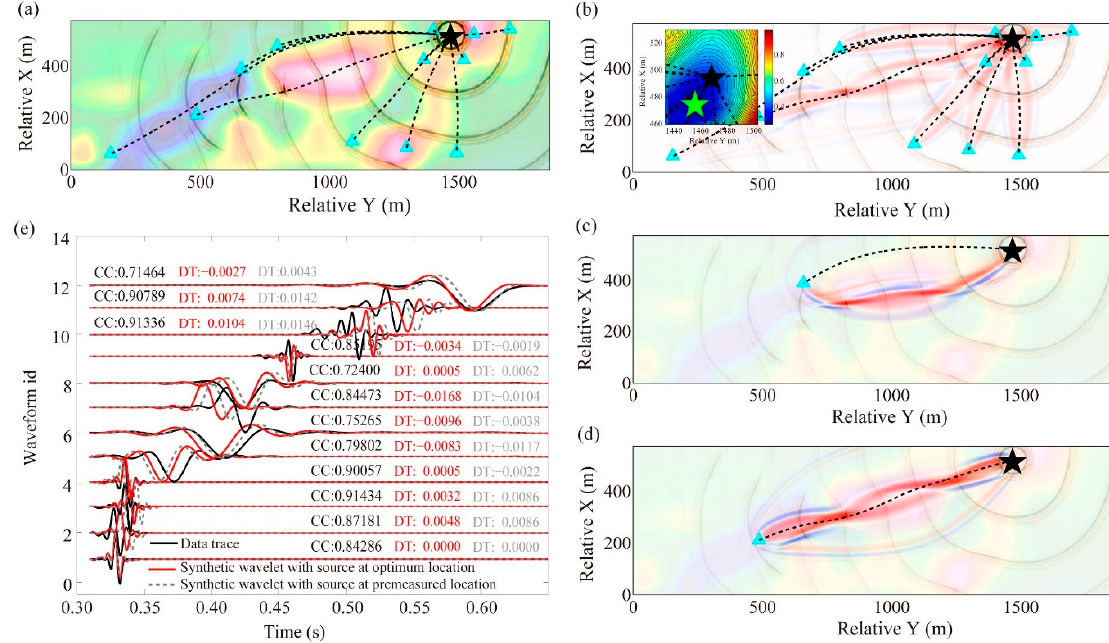
Figure 6. MS-GSWI location results of the blasting event 1. ( a ) Ray paths (black dotted curves) from the MS-GSWI location result to corresponding triggered sensors. The background is a 2D sliced plane of the 3D velocity model, the wavefronts modeled by the SEM are shown at a time interval of 0.04 s. It can be observed that each ray is orthogonal to numerical wave front, demonstrating the effectiveness of the SEM modeling. ( b ) Sensitivity kernels of cross-correlation travel time anomaly from the MS-GSWI location to triggered sensors, which is synthesized by the Gaussian source-time function with a main frequency of 120 Hz. The red to blue color scale shows the intensity value of positive and negative strength of sensitive kernel. The upper left corner shows the misfit contour map of cross-correlation travel time L2 difference between synthetic and observed waveforms. The green and black stars separately indicate the MS-GSWI location and premeasured source location. ( c , d ) Schematic diagrams of typical sensitivity kernels from the MS-GSWI location to two far away sensors. ( e ) Fitting performance of SEM modeled waveforms excited from the MS-GSWI location (red curves) and premeasured source location (grey curves) to the observed waveforms (black curves), and red and grey numbers correspond to their cross-correlation travel time difference to observed waveforms. The cross-correlation coefficients between the DD-SVD-FD wavelet modeled waveforms and observed waveforms were displayed as black numbers.